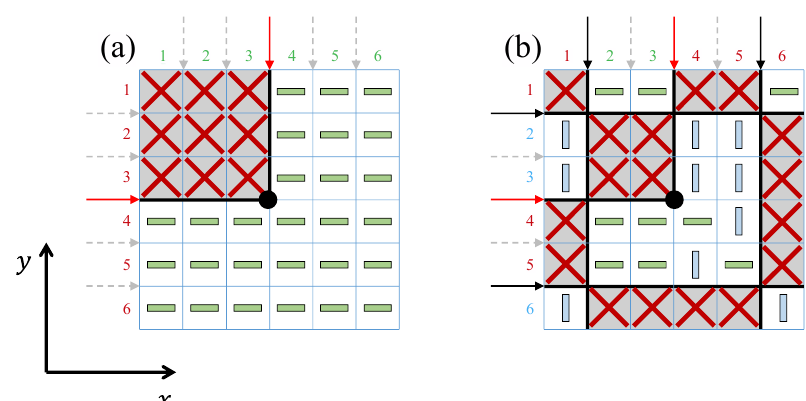
Figure 13: A defect is formed by truncating together a vertical and a horizontal line, indicated by the red arrows. x ( y ) blocks are indicated by green (blue) elongated rectangles. Swappable rows (columns) are numbered in blue (green). (a) A periodic design is constructed by self stacking the presented layer. A non-periodic design can be constructed by swapping any of the columns in (a) or by swapping of permitted columns or rows in (b). Note that switching from columns swapping to row swapping requires going through the presented reference layer.